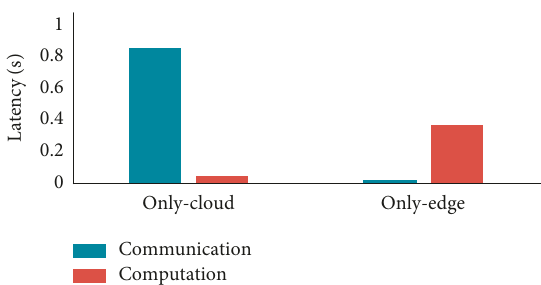
Figure 5: Delay analysis of the AlexNet neural networks under different